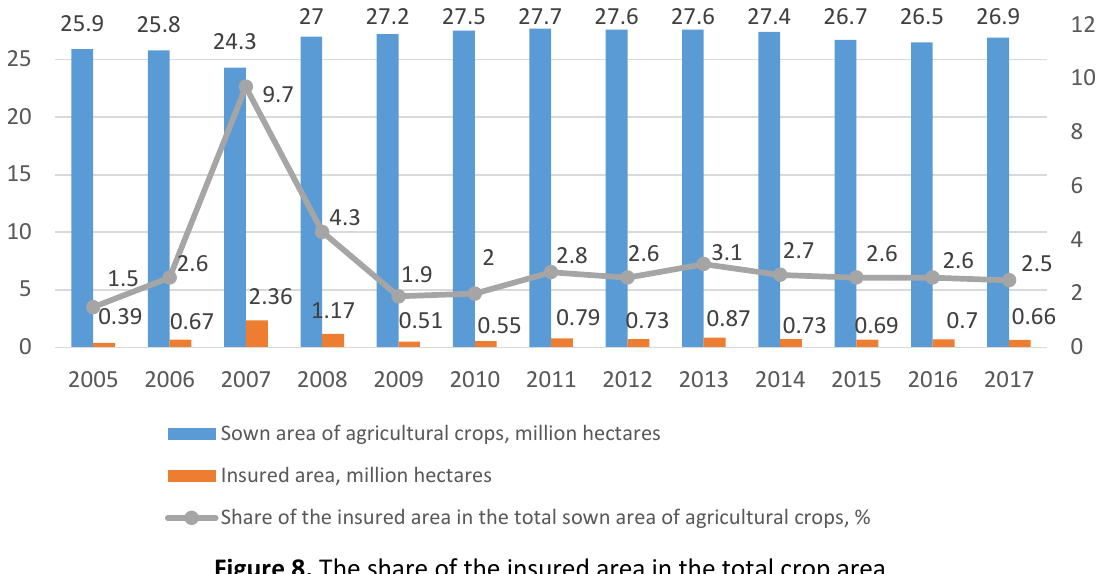
Figure 8. The share of the insured area in the total crop